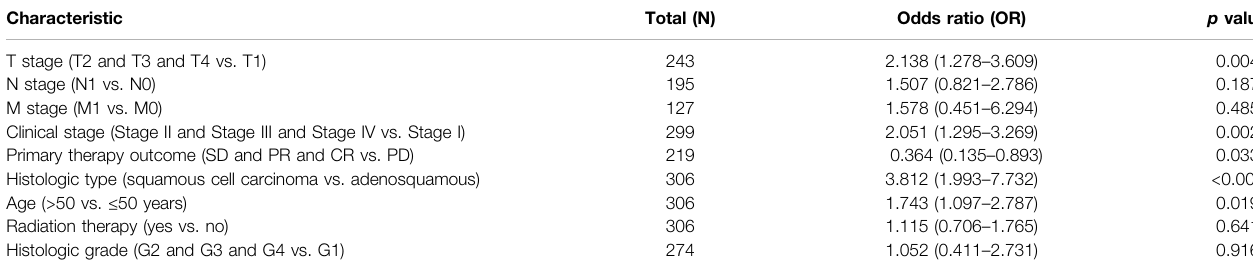
TABLE 2 | SPP1 expression associated with clinicopathologic characteristics by logistic regression. Characteristic T stage (T2 and T3 and T4 vs. T1)